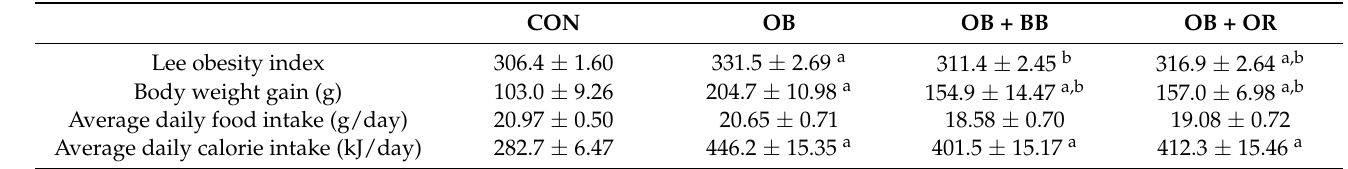
Table 3. Obesity parameters and nutritional composition of rats in the experimental groups. CON OB OB + BB OB +